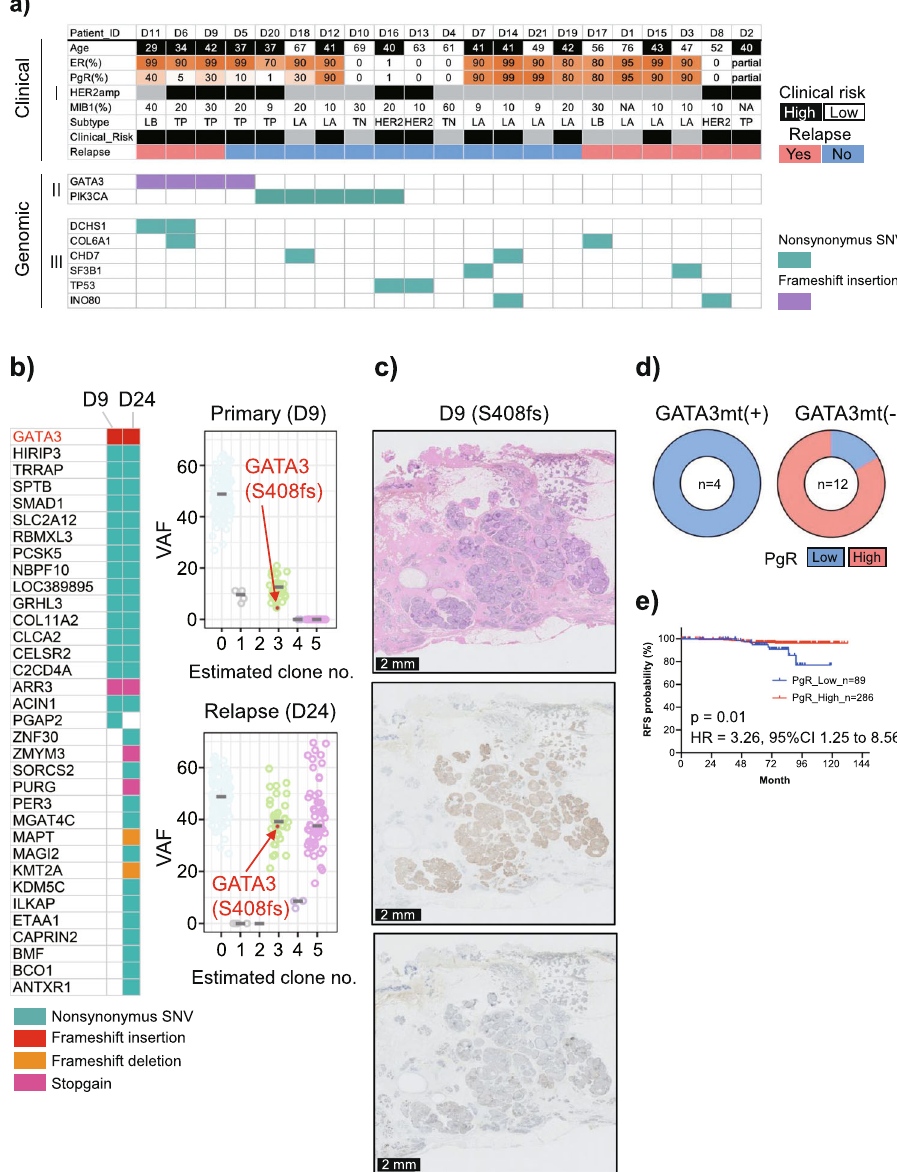
Fig. 1 Selection of clinicopathological and genomic risk factors for relapse. a Results of whole-exome sequencing for 21 patients with primary pure ductal carcinoma in situ (DCIS). I: The clinical information included age; the percentages of estrogen receptor (ER) − , progesterone receptor (PgR) − , and MIB1- positive cells determined by immunohistochemistry (IHC); human epidermal growth factor receptor 2 ( HER2 ) expression status; and relapse status. Patients were subdivided into molecular phenotypes using IHC surrogates (luminal A [ER − /PR + /HER2 − ], luminal B [ER + /PR + /HER2 + or ER + /PR + /HER2 − /MIB1 index high], HER2 [ER − /PR − /HER2 + ], and TN [ER − /PR − /HER2 − ]). Clinical risk estimated by age and HER2 expression status based on the results in Table 1 is shown. II: GATA3 and PIK3CA mutations are shown (red and blue, respectively). Only the results for nonsynonymous mutations are shown. In total, 4 of 21 (19%) patients carried nonsynonymous GATA3 mutations. Nonsynonymous PIK3CA mutations were detected in 5 of 21 (24%) patients. III: The genes that overlapped among patients are shown. Only the results for nonsynonymous mutations are shown. b Comparison of GATA3 mutations between primary and relapse tumors. Left: Comparison of mutations determined via whole-exome sequencing of the primary (D9) and matched relapse lesions (D24) are shown. The same GATA3 mutation (S408fs) was detected in both lesions. Right: Results of subclone analysis obtained using PyClone software are shown. The fi ndings suggest that the subclone carrying the GATA3 mutation also existed in the relapse lesion. VAF variant allele frequency. c Shows HE (upper panel), ER (middle panel), and PgR (lower panel) staining for patient D11 with a GATA3 frameshift mutation (S408fs). Although ER expression was positive, PgR expression was decreased. Scale bars: 2 mm. HE hematoxylin and eosin, VAF variant allele frequency. d Pie charts depicting PgR expression assessed via IHC in 16 ER-positive patients with and without GATA3 mutations. IHC revealed that in patients with ER- positive DCIS, GATA3 mutation was signi fi cantly associated with reduced PgR expression ( P = 0.0192 by Fisher ’ s exact test). e Kaplan – Meier curve for 375 patients with ER-positive DCIS according to PgR expression. High PgR expression was indicated by positive immunostaining in ≥ 70% of cells, and low expression was indicated by positive staining in ≤ 60% of cells. The prognosis of ER-positive patients with low PgR expression was signi fi cantly worse than that of patients with high PgR expression ( P = 0.01 by log-rank test, hazard ratio = 3.26, 95% con fi dence interval = 1.25 –